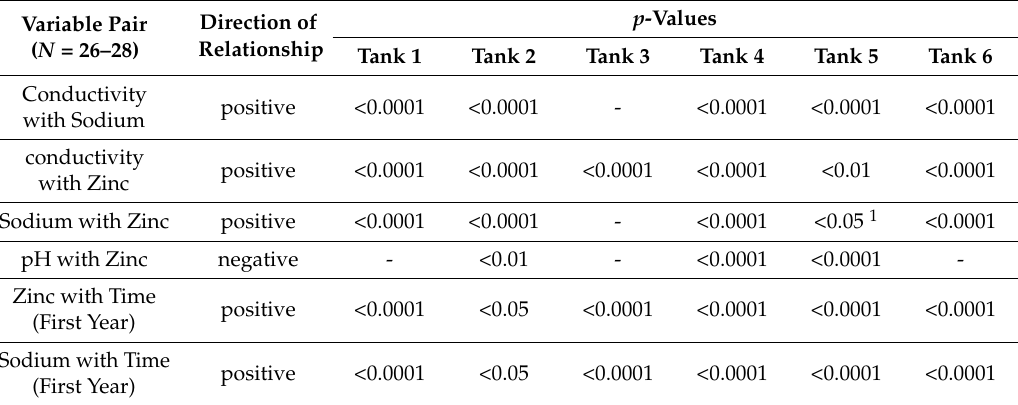
Figure 7. Changes in zinc concentrations in water sampled from each tank over 28 sampling events. Table 6. Linear correlations between conductivity, sodium, zinc, and pH (number of pairs 26–28).